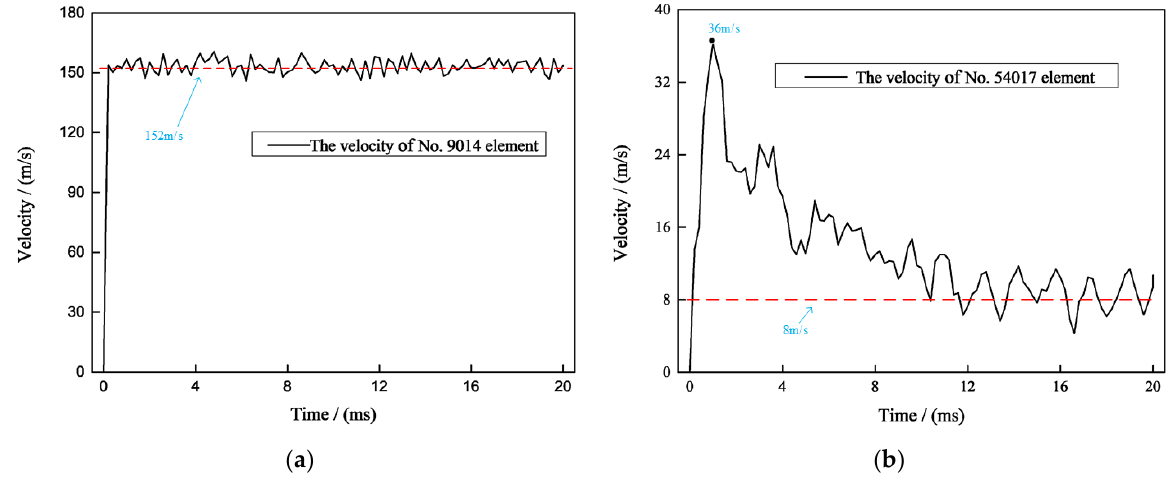
Figure 9. ( a ) No. 9014 ceramic glass element speed change diagram; ( b ) No. 54017 inorganic glass element speed change diagram.